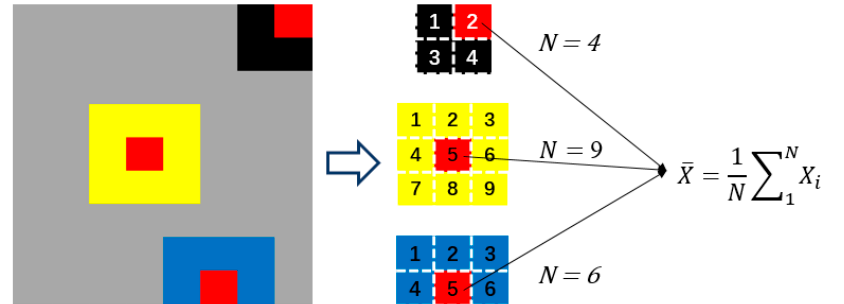
Figure 5. The method of homogenization.